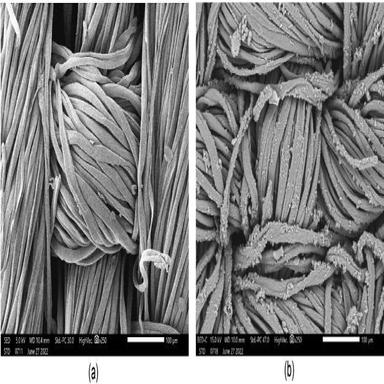
SEM images of (a) Untreated Cotton fabric; (b) PANI-deposited Cotton fabric (250x) magnification.